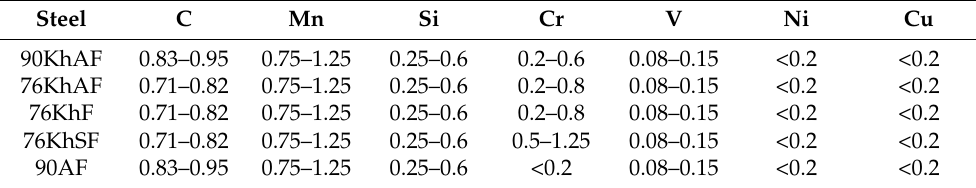
Table 5. Chemical composition of rail steels according to GOST R 51685-2013,